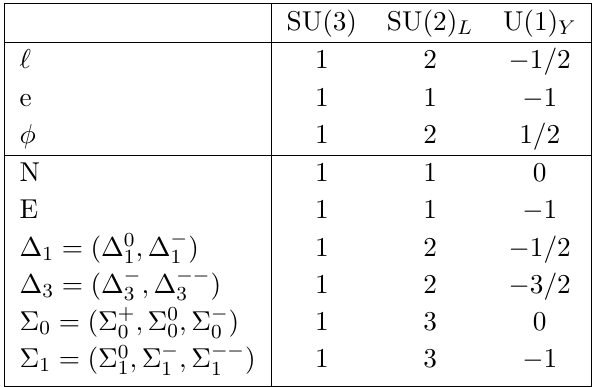
Table 1 . Representations of the SM leptons ( ‘, e ), the SM Higgs Doublet ( φ ) and the VLLs under the SM gauge group.